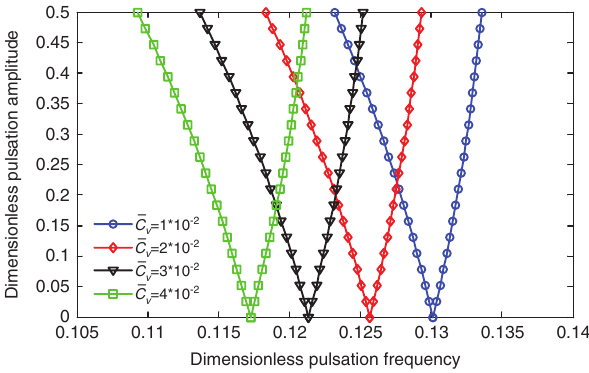
Figure 11: Effect of the damping constants of viscoelastic foundation on the dimensionless pulsation amplitude versus dimensionless pulsation